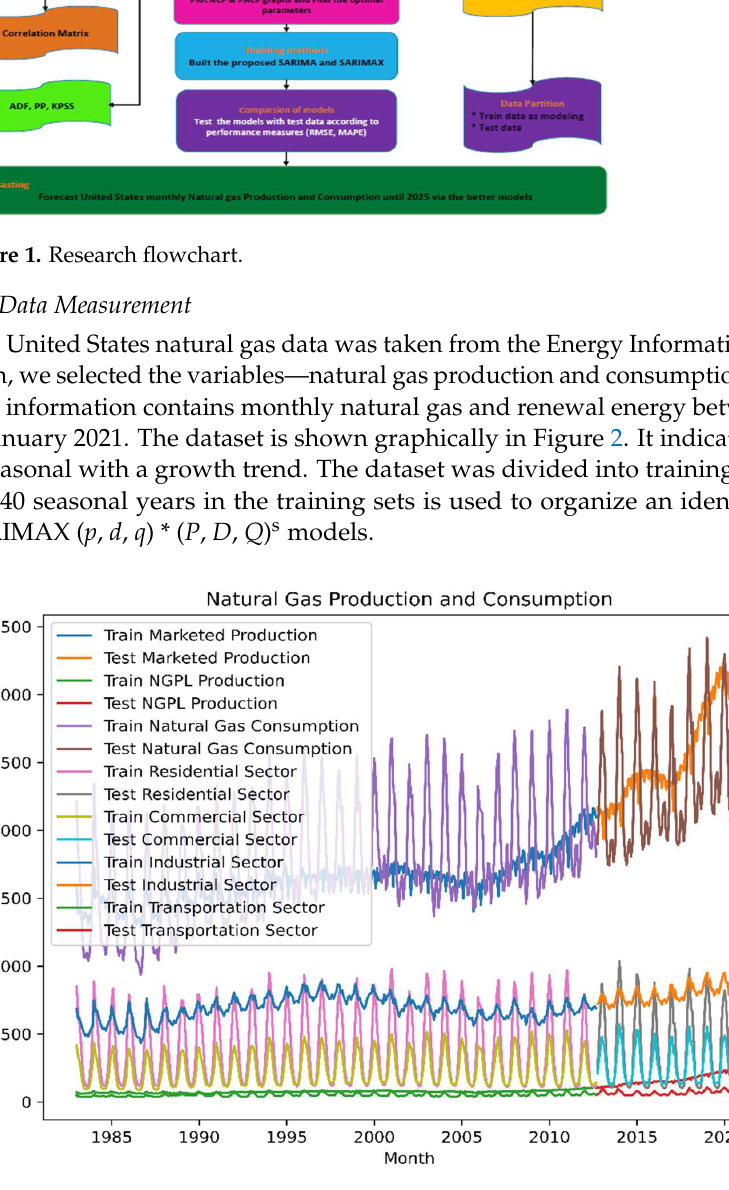
Figure 2. US natural gas production and consumption factors between January 1983 to January 2021.